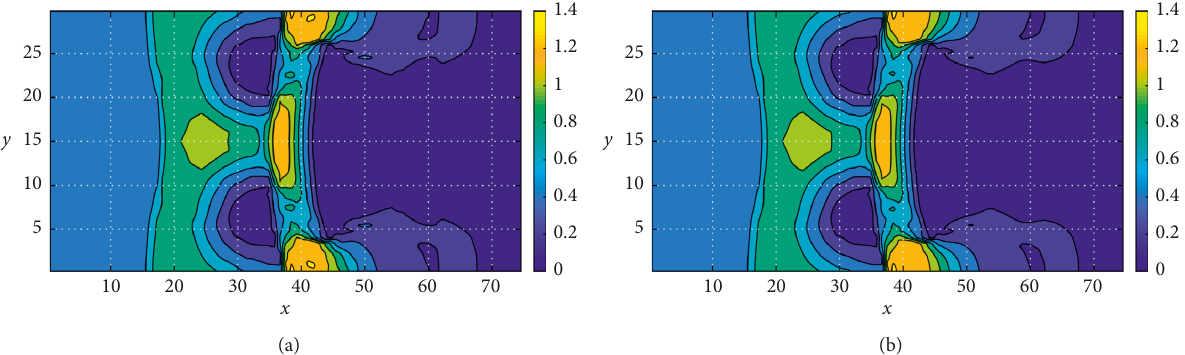
85 (a) and 170 170 (b) grid cells of a dam-break flow over three humps at t × ×